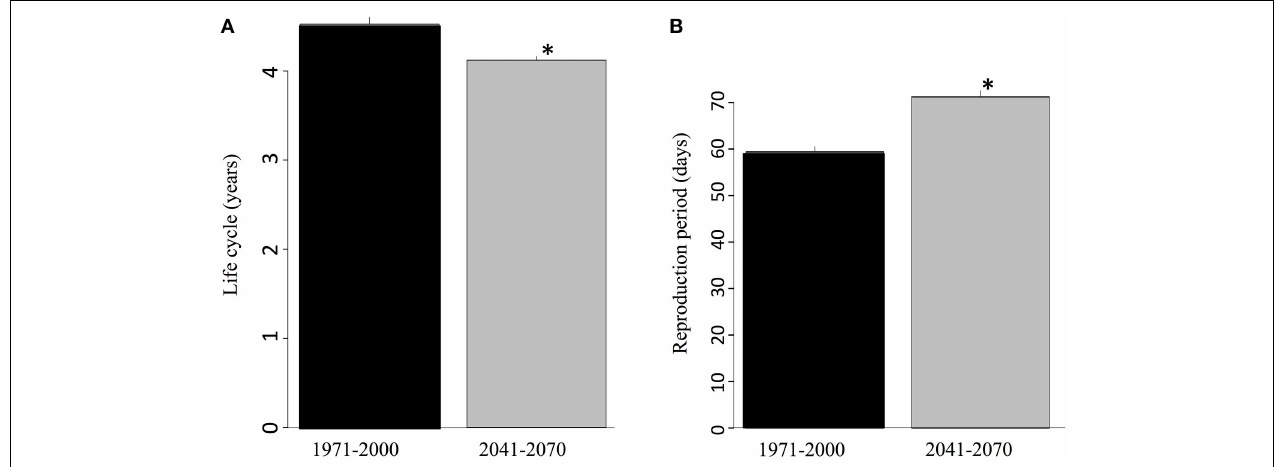
FIGURE 6 | (A) Average number of years for an individual to undergo its entire life cycle (from egg to sexual maturity) for the reference and future periods and (B) length of the breeding season according to the ambient temperature expected for the reference and future